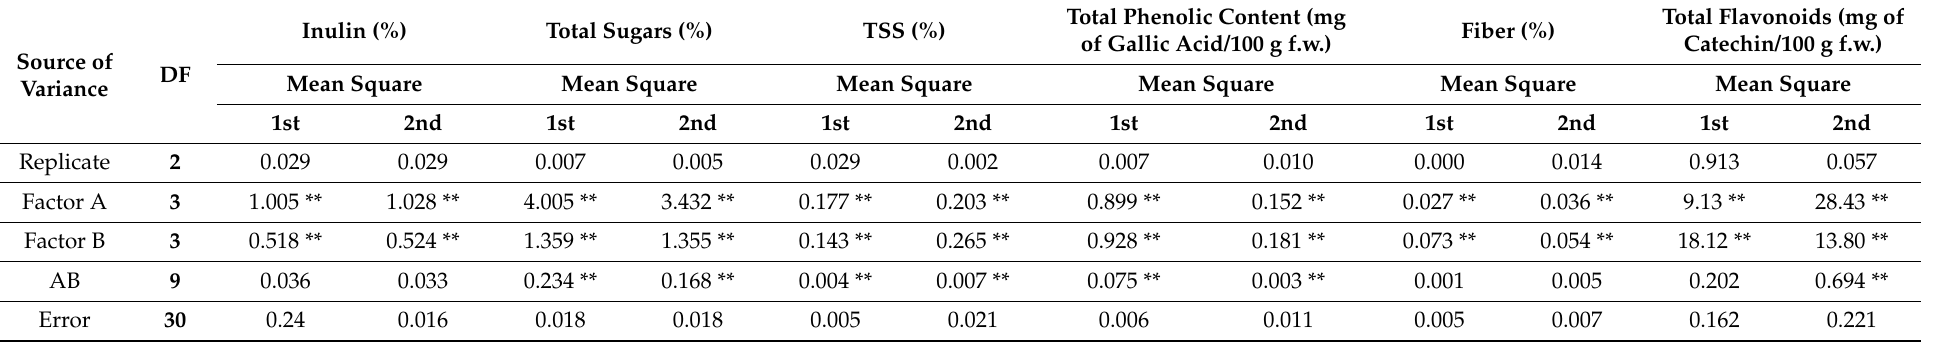
Table 3. The analysis of variance (ANOVA) for the effect of potassium sources (Factor A), seaweed extract application (Factor B), and their interaction (AB) on different parameters studied during the 2019 (1st) and 2020 (2nd) season.